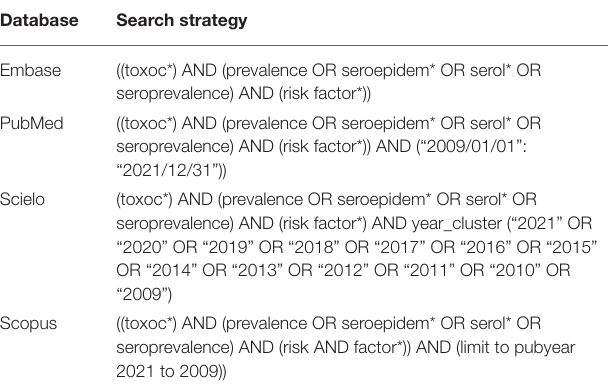
TABLE 1 | Search strategy in different databases utilized for meta-analysis for assessment of contact with dogs and cats as associated risk factor for toxocariasis from 2009 to